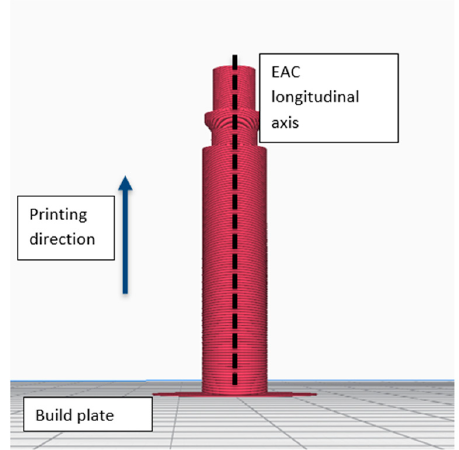
Figure 2. Revolved sketch ( a ) (all dimensions are in mm) and ( b ) 3D model of the embedded air connector (EAC).